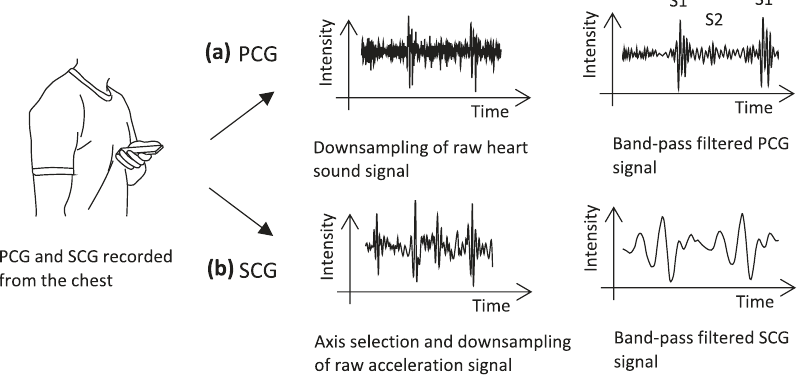
Fig. 4 Construction of the phonocardiogram (PCG) and seismocardiogram (SCG) signal from recordings of heart sound and heart vibrations. The work fl ows depicted in a and b correspond to the PCG and SCG signal respectively. After the data are recorded, they are typically downsampled. Subsequently, a band-pass fi lter is applied. S1 and S2 are the two main heart sounds, representing the closure of the mitral and tricuspid valves, and the closure of the aortic and pulmonary valves, respectively.